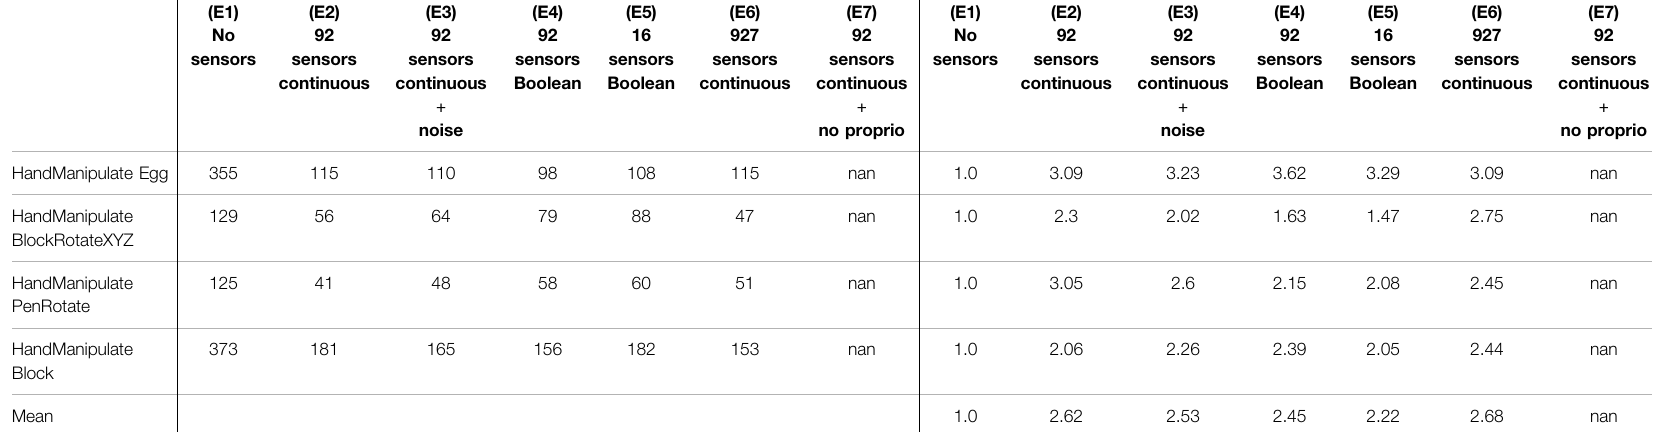
TABLE 5 | Experiments E1 – E7 ( Figure 4 ): Convergence Epoch (columns 2 – 8) and Sample-Ef fi ciency Ratio (columns 9 –